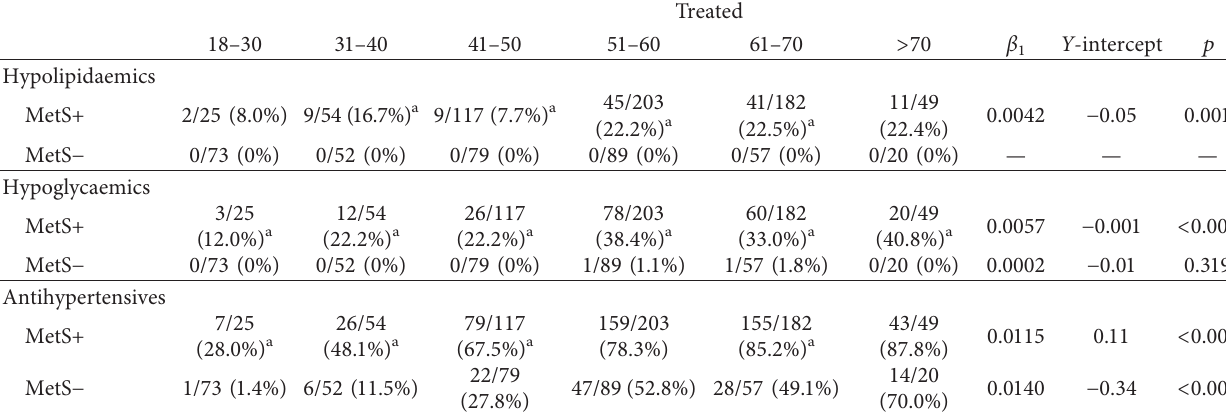
Table 4: Obese patients with or without metabolic syndrome, subdivided among age ranges, treated with hypolipidaemic drugs, hypoglycaemics, and/or antihypertensives.